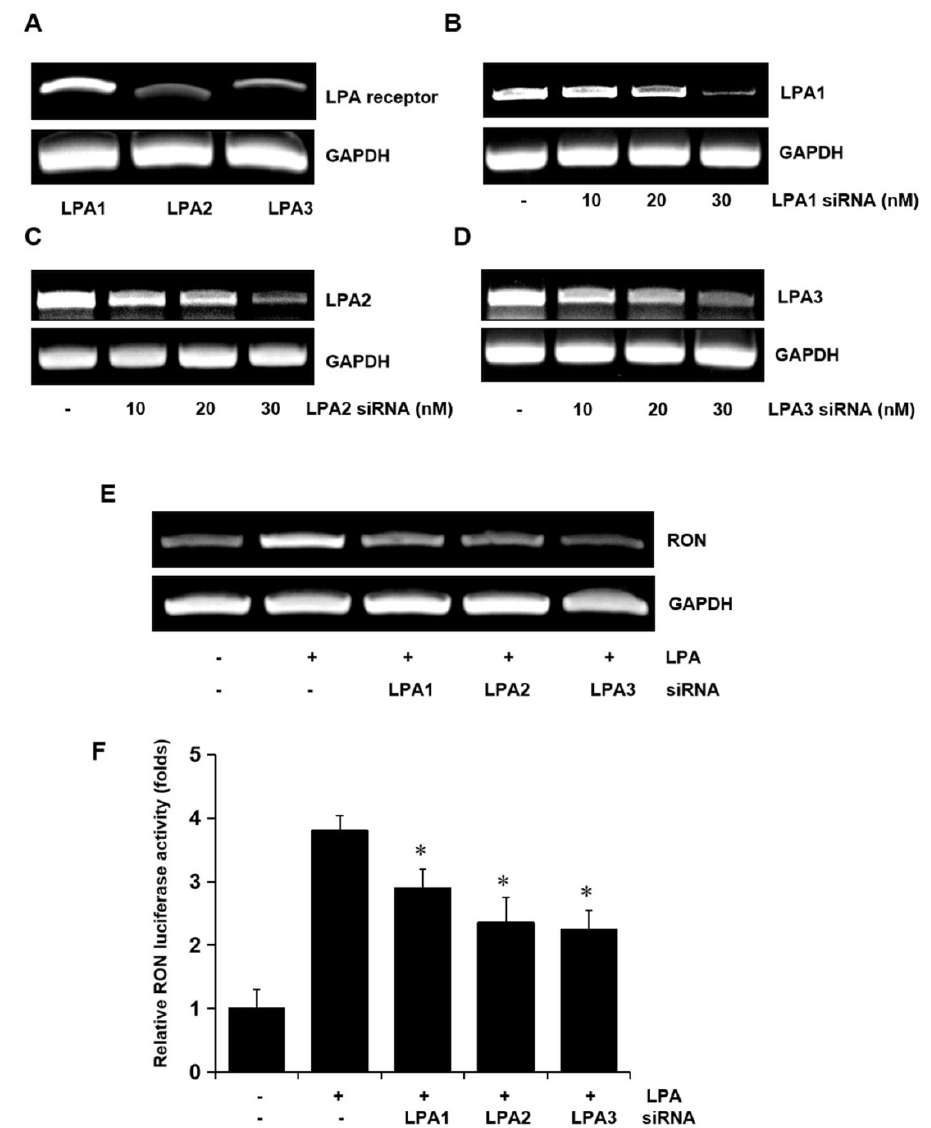
Figure 3. Involvement of LPA receptors in LPA induced RON expression in T24 human bladder cancer cells. ( A ) Total RNA was extracted from T24 cells, and the mRNA levels of LPA1, LPA2, LPA3, and GAPDH were analyzed by RT-PCR. ( B – D ) T24 cells were transiently transfected with specific LPA1, LPA2, and LPA3 siRNA oligonucleotides (0–30 nM) for 5 h. After stabilization for 48 h, the amount of LPA1, LPA2, LPA3, and GAPDH mRNAs was determined by RT-PCR. ( E ) T24 cells transfected with 20 nM LPA1, LPA2, and LPA3 siRNA oligonucleotides were incubated with 5 μM LPA for 8 h, and then, RT-PCR was performed. ( F ) T24 cells transfected with specific LPA1, LPA2, and LPA3 siRNAs for 48 h were transiently transfected with a RON promoter reporter construct overnight. The transfected cells were incubated with 5 μM LPA for 8 h, and luciferase activity was measured with a luminometer. Bars show the mean standard deviation from three measurements. * p < 0.05 vs. LPA only.